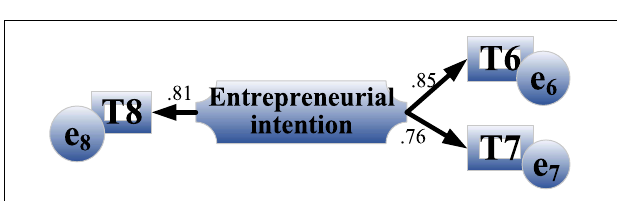
FIGURE 9 | Results of confirmatory factor analysis of entrepreneurial values scale.